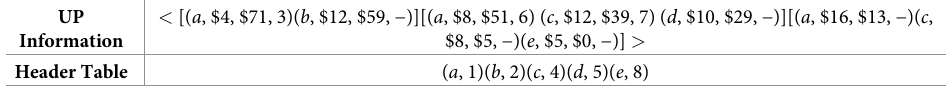
Table 3. The Utility-Linked (UL)-list structure of S 4 . UP Information Header Table